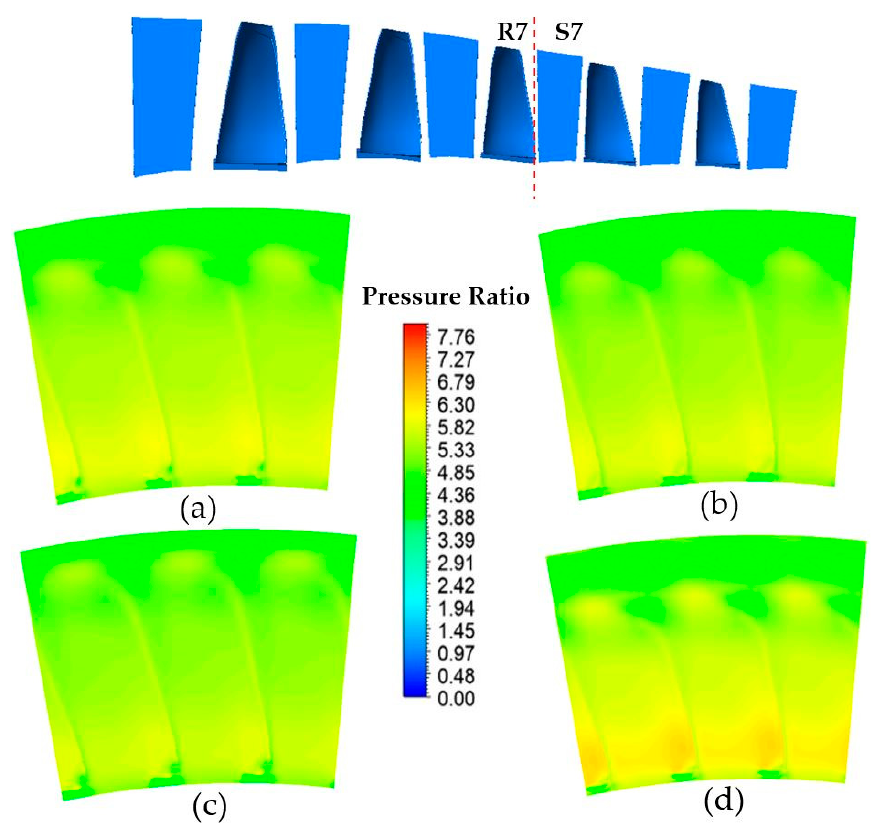
Figure 9. Pressure ratio between the middle plan of R7–S7 of the blade: ( a ) before modification, after modifications of ( b ) 1 mm, ( c ) 5 mm, and ( d ) 10 mm.